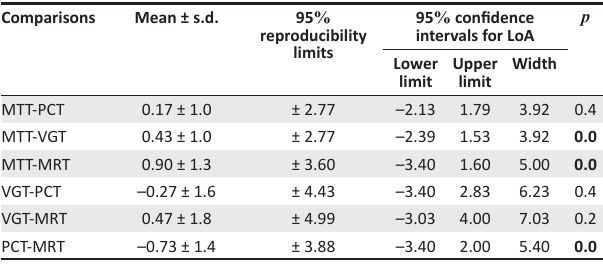
TABLE 4: Mean differences of heterophoria measures in prism dioptres with 95 % reproducibility limits ( ± 1.96 √2 SD ≈ ± 2.77 SD ) and 95 % limits of agreement. Comparisons Mean ± s.d.